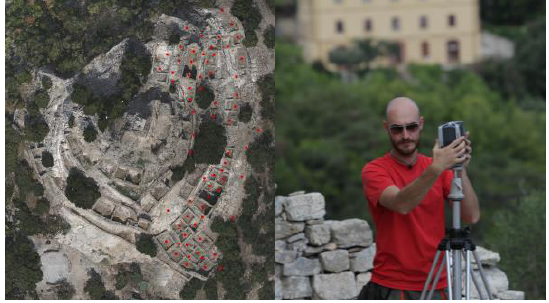
Figure 9. TLS acquisitions (right) and scans position (left)